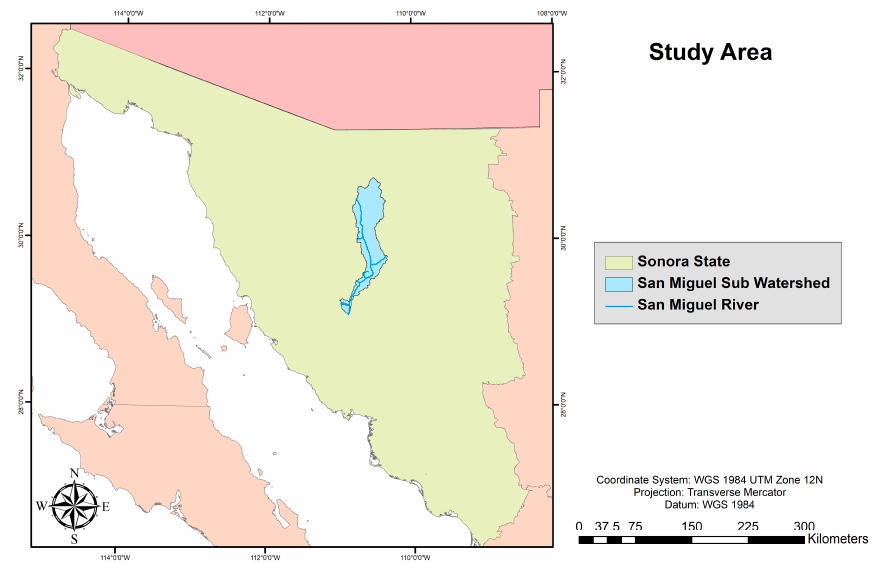
Figure 1. Location of study area.